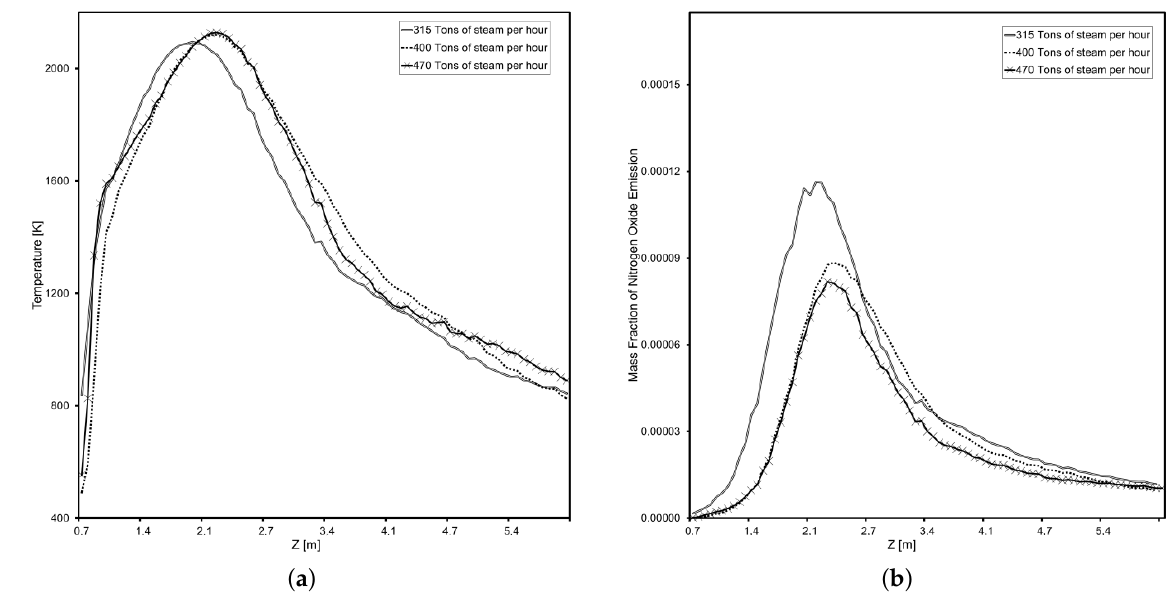
Figure 7. The study of the release of harmful substances at various steam loads of the E-500-13.8- 560GMN type boiler: ( a ) comparison of temperatures; ( b ) comparison of NO X emissions.